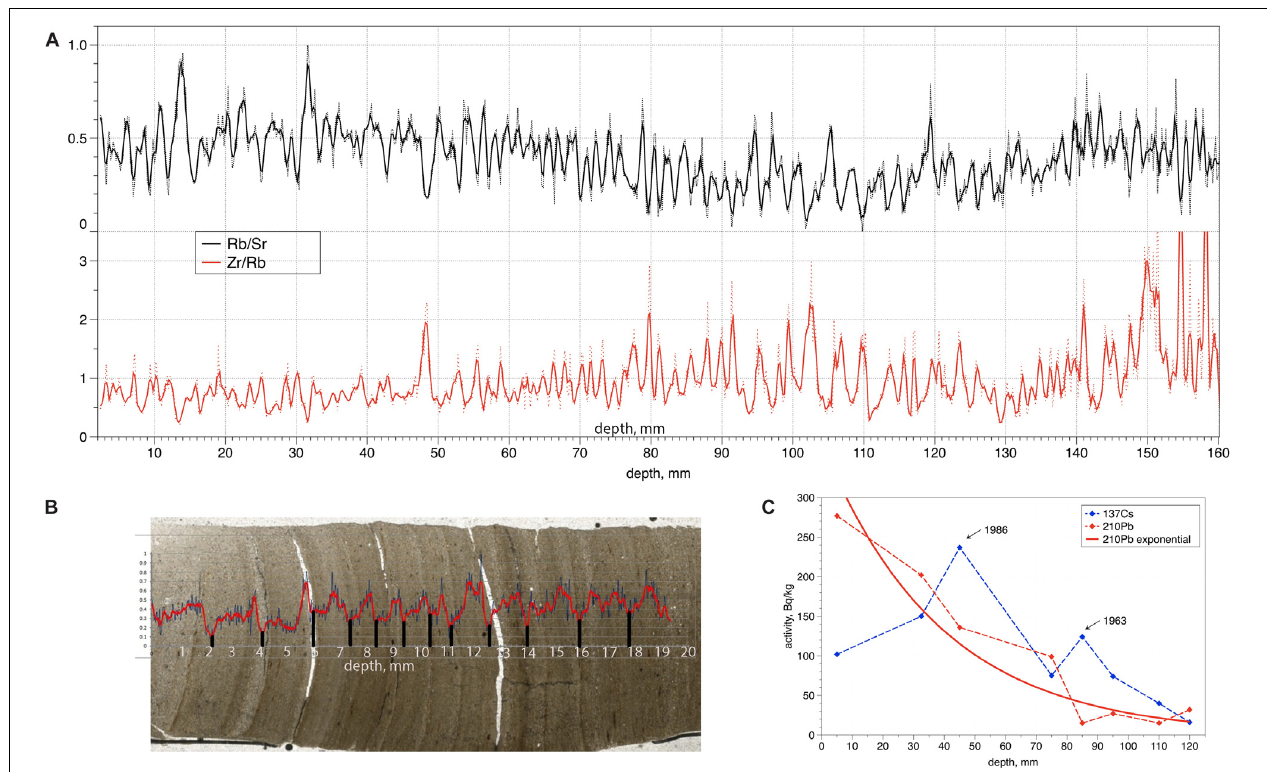
FIGURE 6 | (A) Profiles of Rb/Sr and Zr/Rb ratios used as markers of annual layers. Dashed lines indicate measured data, solid lines: 3-point averaged; (B) Rb/Sr profile for the upper 20 mm obtained using concentrating X-ray optics at 30 µ m resolution superimposed on the photographic image; (C) 137 Cs and 210 Pb dating